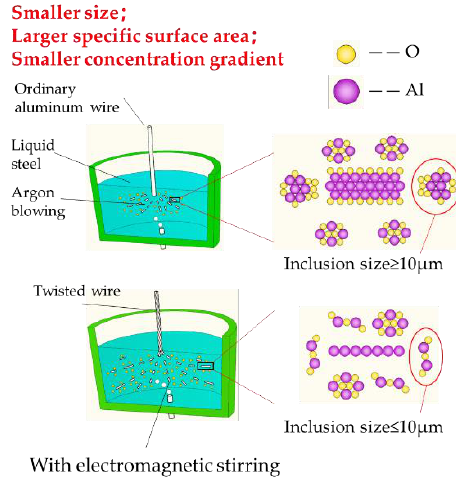
Figure 10. Principle of multi-point regional micro-supply processing of twisted wire by comparing that of ordinary wire.